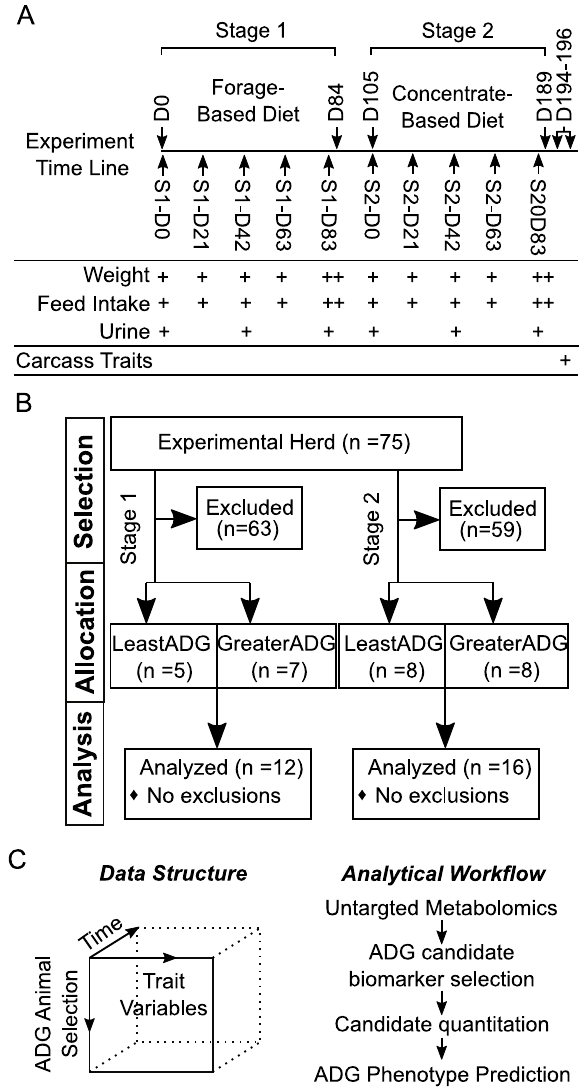
Figure 8. Graphical summary of study design. MARC Nutritional feeding study ( A ) time line and animal traits measured ( B ) selection of animals for greater and least average daily gain with similar average dry matter intake in stage-1 and stage-2 ( C ) characteristics along with the data and data analysis workflow covered in the current